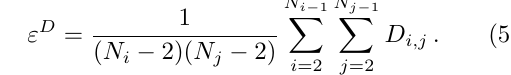
Table 2. Values of the two-point probability error ε S 2 , depending on the number of layers n r number of neurons in each layer n r n